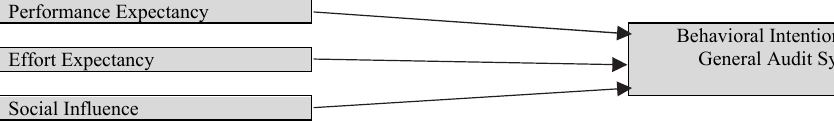
Fig. 2. The research